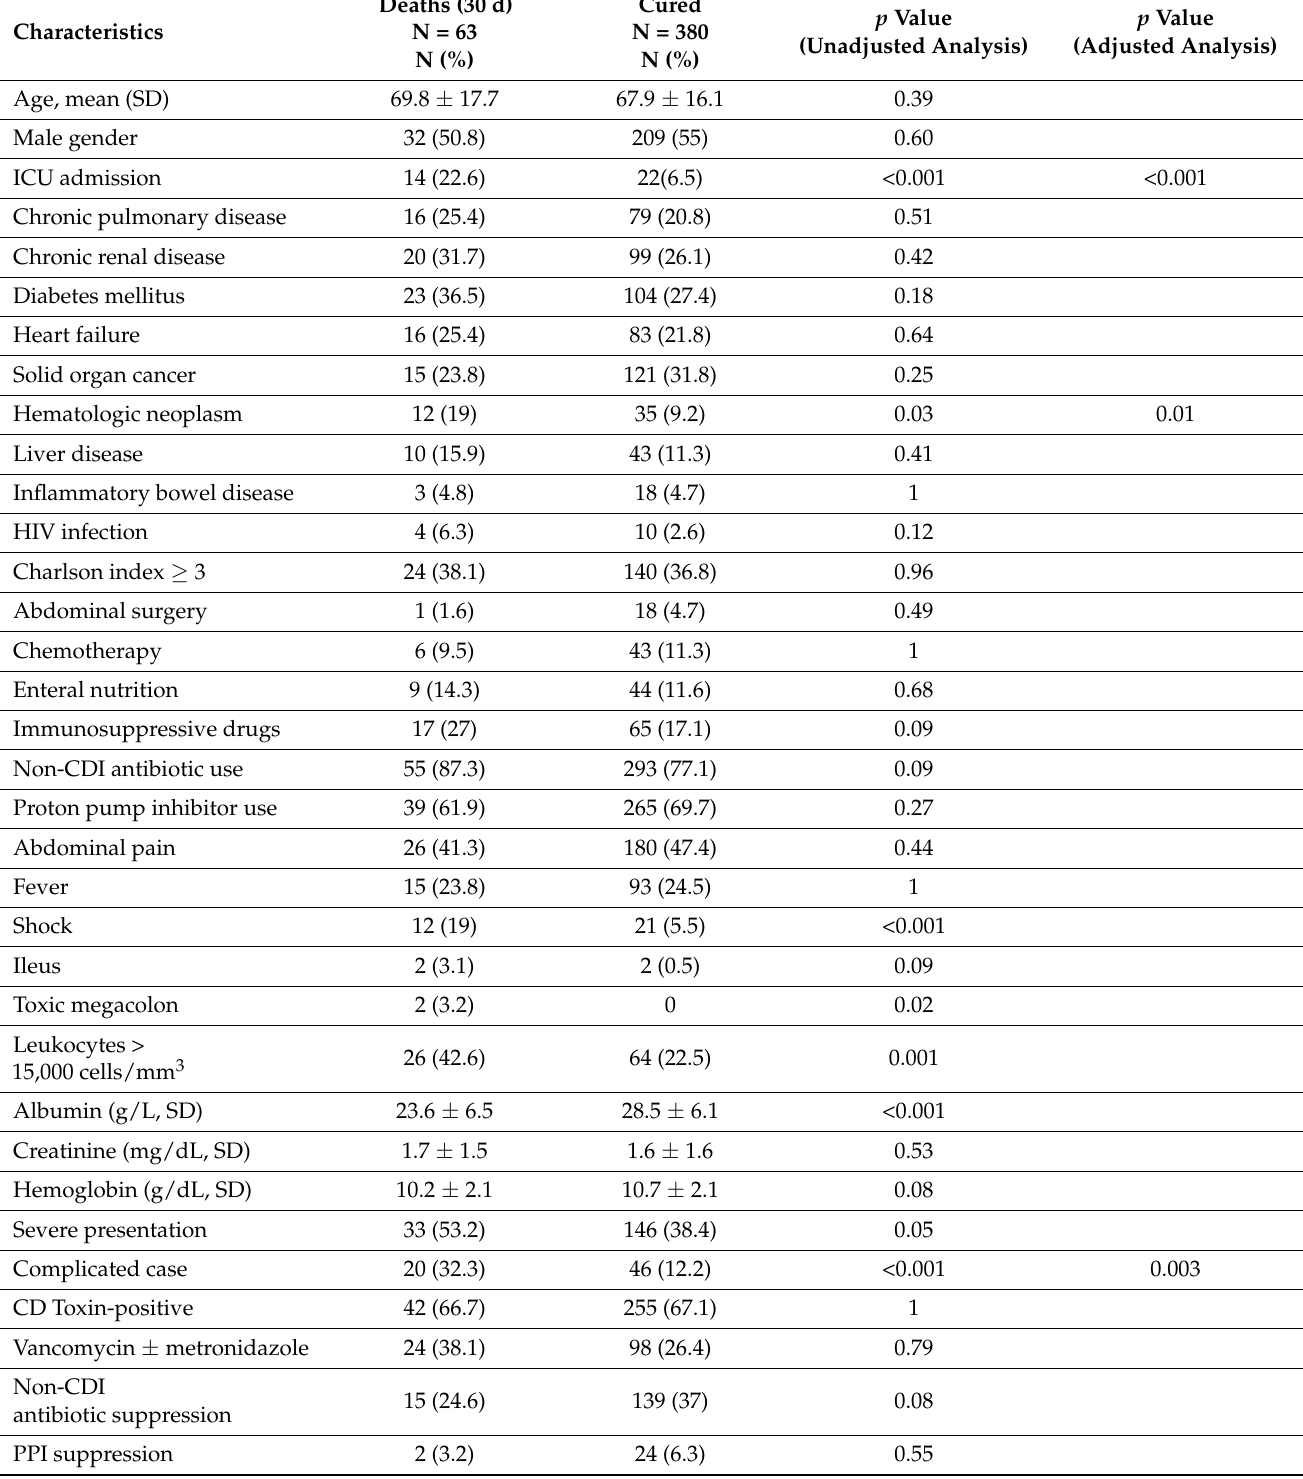
Table 3. Univariate and multivariate predictors of death (30